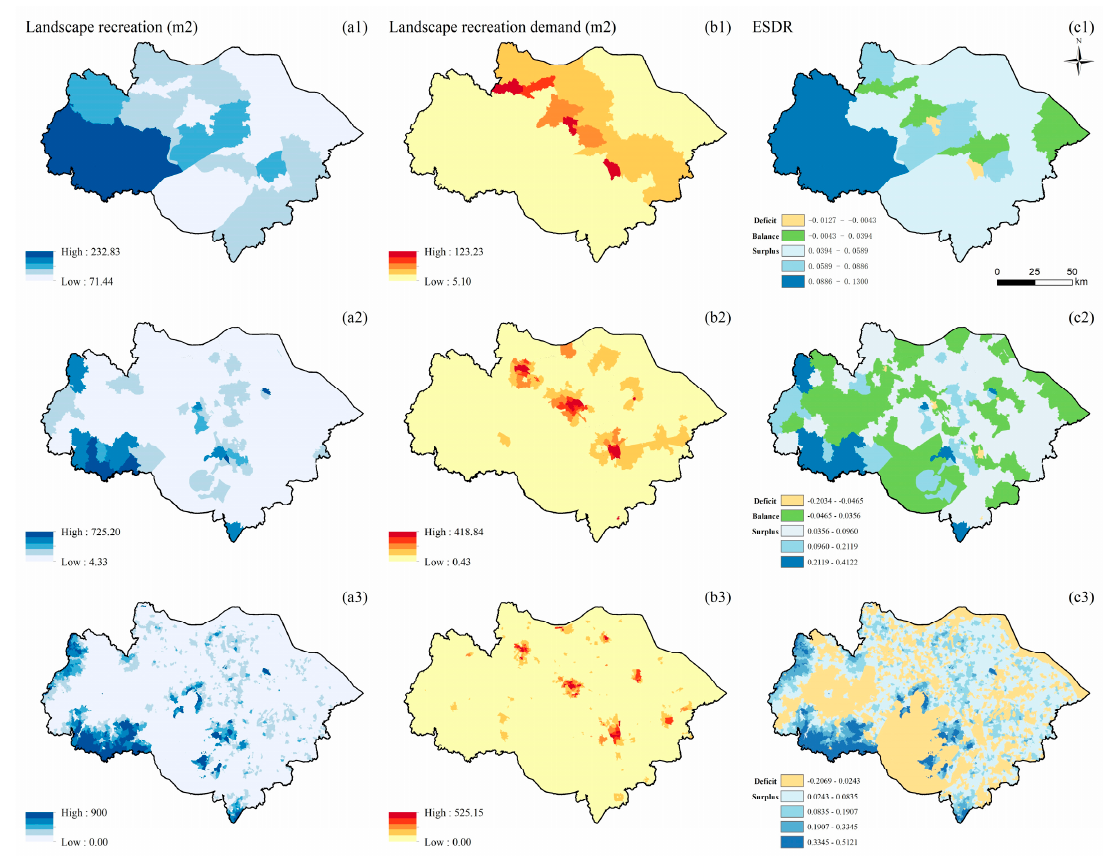
Figure 7. Spatial distribution of LR (unit: m 2 /900 m 2 ) at the county ( a1 , b1 , c1 ), township ( a2 , b2 , c2 ), and village ( a3 , b3 , c3 ) scales; supply of LR ( a1 – a3 ); demand for LR ( b1 – b3 ); ESDR ( c1 – c3 ).